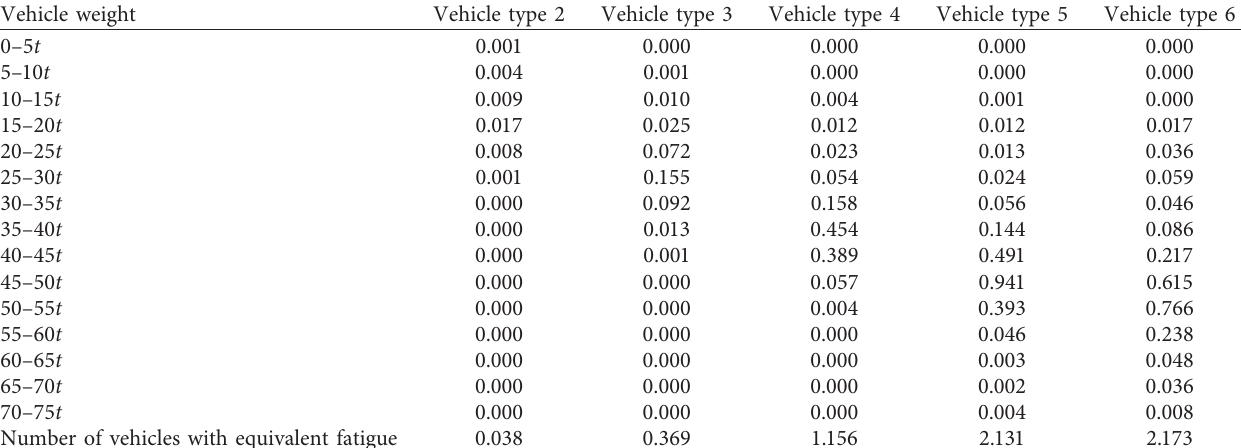
Table 3: Equivalent number of vehicles corresponding to fatigue design load for different vehicle